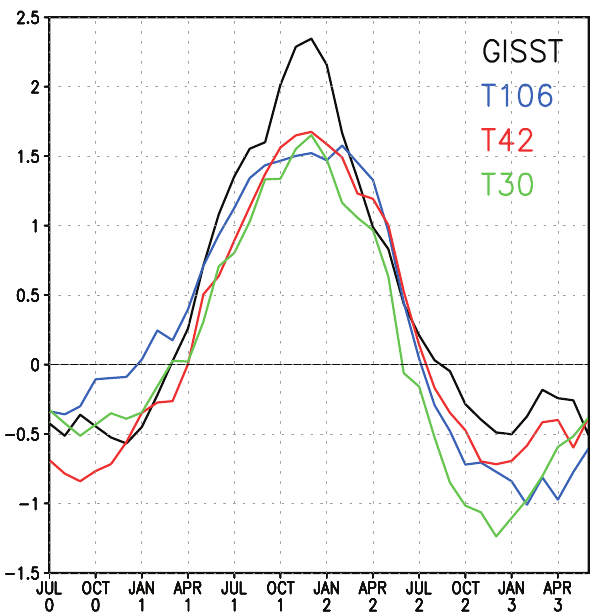
Fig. 12. Composite of the NIÑO-3 SST anomaly. The composite have been computed by averaging the monthly anomalies corresponding to ENSO events for which the NIÑO-3 index is larger than 1.5 standard deviation. In the GISST case (black curve) 8 episodes have been considered (year 1957-58, 1965-66, 1972- 73, 1982-83, 1986-87, 1991-92 and 1997-98). For the T106 model (blue line), 12 events have been used to yield the composite; whereas, for the T42 (red curve) and the T30 (green curve) 21 episodes have been used. Vertical axis: °